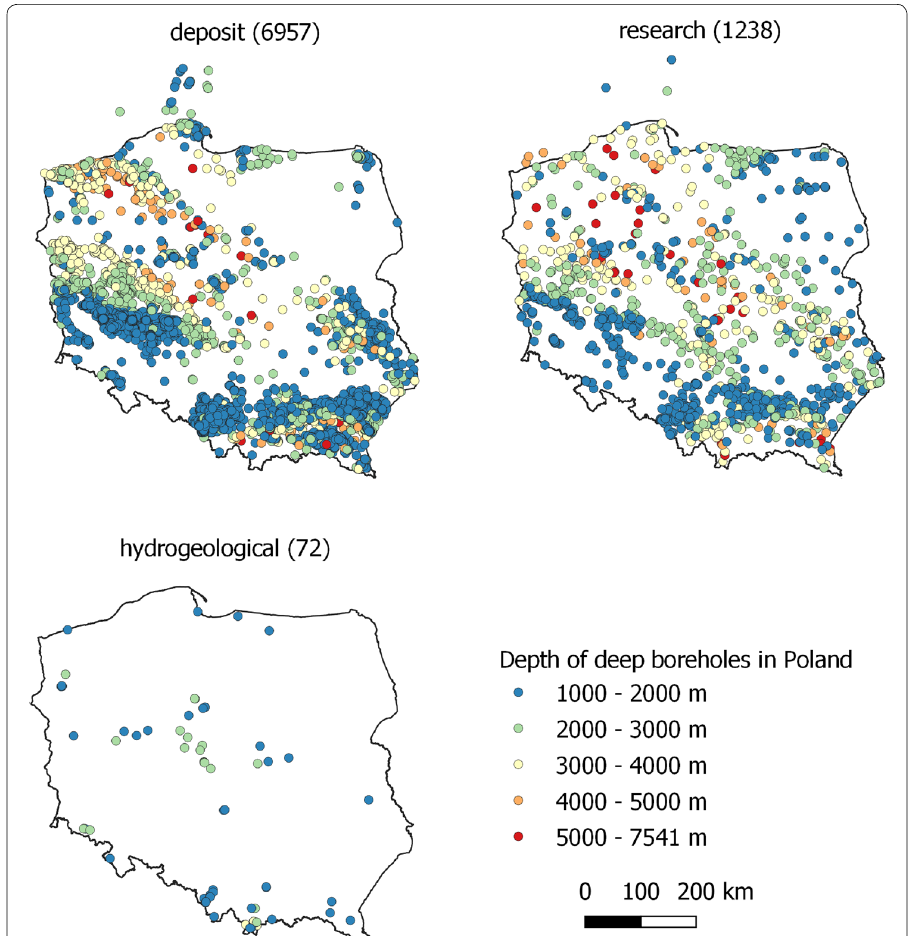
Fig. 2 Spatial distribution of deep boreholes in Poland, classified according to the aim of drilling and their